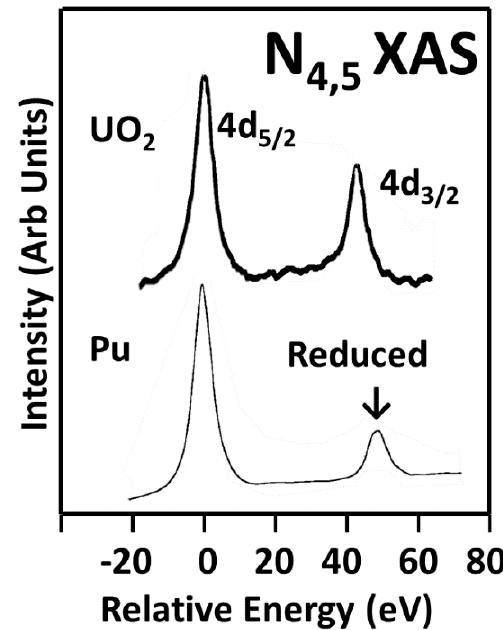
Figure 1. The N4,5 X-ray Absorption Spectroscopy (XAS) of uranium dioxide and δ -Pu(Ga) are shown here. Note the significant reduction in the intensity of the Pu 4d 3/2 peak relative to that of the U in uranium dioxide. (The spectra are normalized with the 4d 5/2 level.) This has been shown to be due to the population of the 5f levels: n = 2 for UO 2 and n = 5 for Pu. [2,10,11] The UO 2 spectrum is courtesy of DK Shuh, Lawrence Berkeley National Laboratory (LBNL).